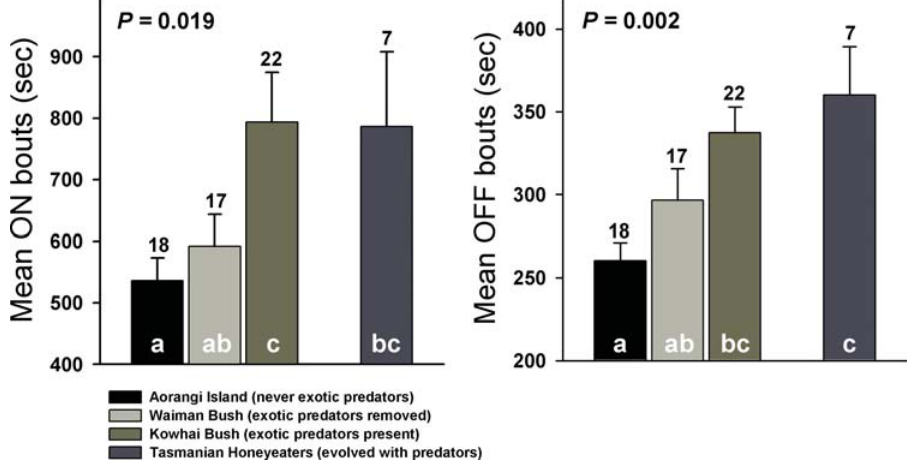
Figure 3. The mean time females spent on the nest per incubating bout (mean on-bouts) and the mean time females spent away from the nest (mean off-bouts) for bellbirds on Aorangi Island, where exotic predators were never introduced, for bellbirds in Waiman Bush, where exotic predators were removed, for bellbirds in Kowhai Bush, where all exotic predators are present, and for honeyeaters in Tasmania, which evolved with a range of native mammalian predators. Shared letters within bars denote non-significant (i.e., p . 0.05) statistical differences based on LSD tests. Figures above bars are the number of nests filmed in each study site.